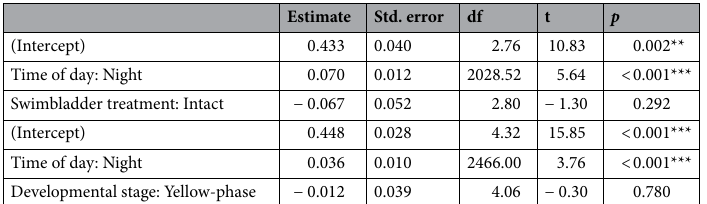
Table 3. Summary of linear mixed models fitted for swimming speeds in body length per second. Signif. codes: 0 ‘***’ 0.001 ‘**’ 0.01 ‘*’ 0.05 ‘.’ 0.1 ‘ ’